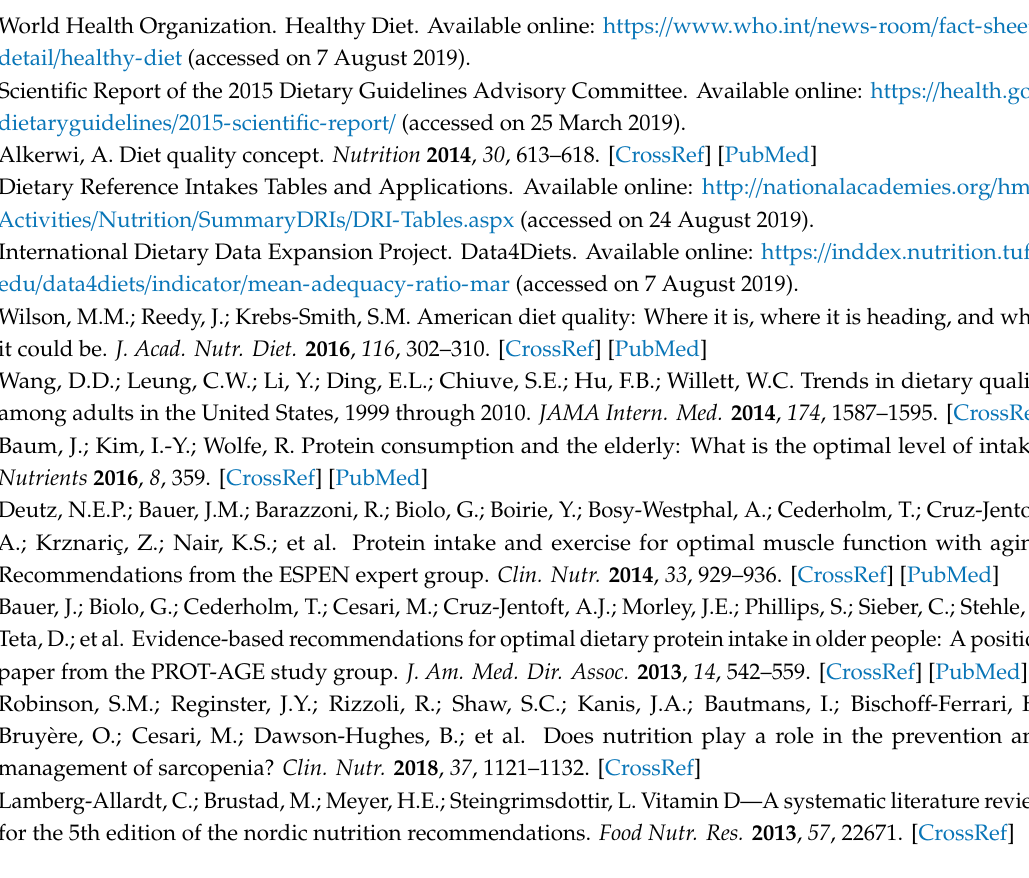
Table S1. MAR and NAR scores of HANDLS study sample at Baseline, wave 3 and wave 4, Table S2: Mixed e ff ects regression with Mean Adequacy Ratio as an outcome: Baseline, waves 3 and 4 Healthy Aging in Neighborhoods of Diversity across the Life Span study, Table S3. Comparison of biomarkers for normal nutritional status and at-risk for malnutrition groups: Wave 4 of HANDLS study, Table S4: Predictors of risk for malnutrition determined by Mini Nutritional Assessment Score of Wave 4 HANDLS study